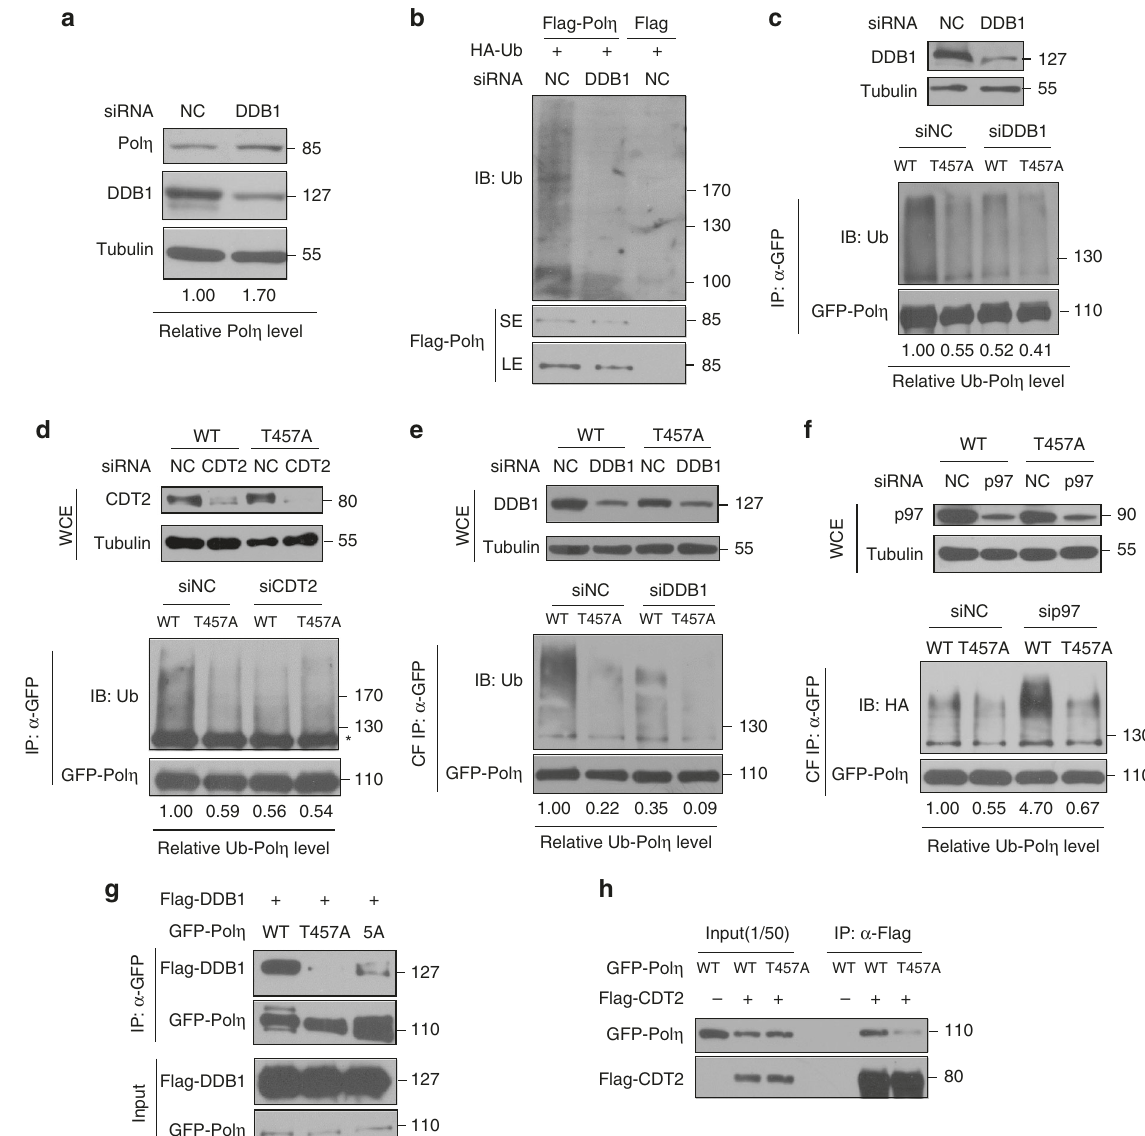
Fig. 4 T457A impairs CRL4 CDT2 -mediated Pol η polyubiqitination. a 293T cells were transfected with siDDB1 or siNC oligos. Seventy-two hours later, the cells were harvested and the protein levels of Pol η and DDB1 were detected by western blotting. Tubulin: loading control. b Flag empty vector or Flag-Pol η and HA-Ub were transfected in siNC- or siDDB1-treated 293T cells. The cells lysates were immunoprecipitated by anti-Flag M2 beads and analyzed by immunoblotting with anti-Ubiquitin and anti-Flag antibodies. SE short exposure, LE long exposure. c , d WT or T457A GFP-Pol η and HA-Ub were transfected into siDDB1-treated c or siCDT2-treated d 293T cells. The lysates were immunoprecipitated using GFP-Trap A. The immunoprecipitates were analyzed via western blotting using anti-GFP and anti-Ubiquitin antibodies. The protein levels of DDB1 and CDT2 were detected by immunoblotting. WCE whole cell lysate. Tubulin: loading control. Asterisk denote non-speci fi c signal. e WT or T457A GFP-Pol η and HA-Ub were transfected into siDDB1-treated 293T cells. The chromatin fractions (CF) were harvested followed by immunoprecipitation with GFP-Trap A. The immunoprecipitates were analyzed as in c . f WT or T457A GFP-Pol η and HA-Ub were transfected into p97 siRNA (sip97)-treated 293T cells. The chromatin fractions were immunoprecipitated and analyzed as in c . The p97 protein level was detected by western blot. g Flag-DDB1 and GFP-Pol η (WT, T457A, or 5A) were transfected into 293T cells. The lysates were immunoprecipitated using GFP-Trap A. The immunoprecipitates and inputs were examined via western blotting using anti-GFP and anti- Flag antibodies. h Flag empty vector or Flag-CDT2 and GFP-Pol η (WT or T457A) were transfected into 293T cells. The lysates were immunoprecipitated and analyzed as in